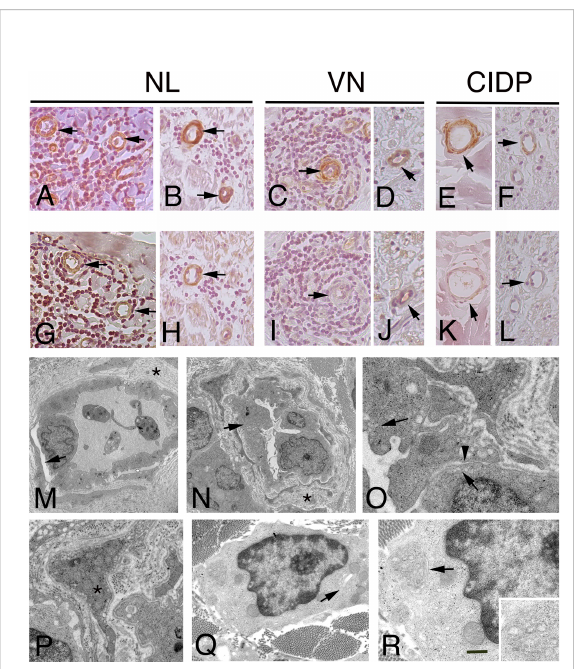
FIGURE 3 Immunohistochemistry localization of ACTA1 and desmin in NL and control nerves. ultrastructural analysis of endoneurial blood vessels in NL. Staining for ACTA1 shows increase expression in NL sural nerves. ACTA1 immunoreactivity was present in the epineurium (A) , arrows and endoneurium (B) , arrows in endothelial cells and pericytes-like cells in the proximity of malignant B-cells in patients with SMPN (A) and MN (B) . Similarly, ACTA1 shows a weak immunoreactivity in both epineurial (C , E) , arrows and endoneurial blood vessels (D , F) , arrows in control nerves. Desmin shows immunoreactivity in endothelial cells and pericytes-like cells in the epineurium and endoneurium in NL nerves from patients with SMNP (G) , arrows mark blood vessels in epineurium) and MN (H) , arrow marks an endoneurial blood vessel; in VN and CIDP sural nerves, immunoreactivity was almost negative or weak in epineurial and endoneurial blood vessels (I - L) , arrows. In NL sural nerves, electron micrographs showing abnormal endothelial cells and pericytes on blood vessels in sural nerve of patients with NL. Initial detachment of pericytes from endothelial cells (M) , arrow. Endoneurial capillaries showing hypertrophic endothelial cells (N) , arrow occluding the lumen. The basement membrane at the outer surface of the endothelial cells is increased in thickness asterisks, (M, N) and reduplicated; endothelial cells showing increase pinocytic vesicles (O) , arrows and loss of endothelial thigh junctional integrity (O) , arrowhead. Abnormal pericytes dropout from the endothelial cells (P) , asterisk. Malignant B-cells in the endoneurium between fi brotic scar (Q) . Note the cytoplasm with virtually no rough endoplasmic reticulum and the granularity of the cytoplasm results from the numerous polyribosomes. A small Golgi complex (Q) , arrow is present in one tumour cell and an abnormal residual rough endoplasmic reticulum (R) , arrow and high magni fi cation). Scale bar represent 50µm (A - L) ; 2 m m (M , N) ; 1 m m (P , Q) , 500nm (O , R)